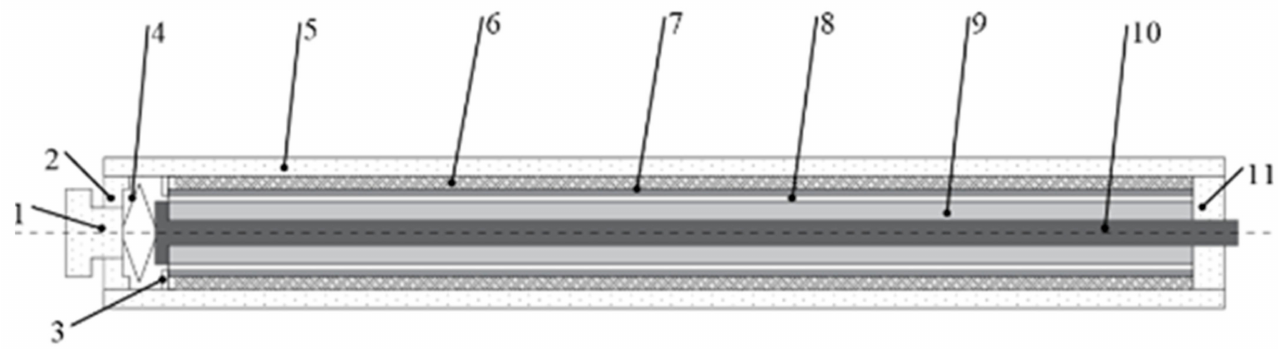
Figure 1. Schematic diagram of GMA structure for direct-drive injector. (1) Tightening bolt; (2) Upper end cover; (3) Baffle; (4) Disc spring; (5) Shell; (6) Excitation coil; (7) Coil skeleton; (8) Air gap; (9) GMM cylinder; (10) “T” plunger; (11) Lower end